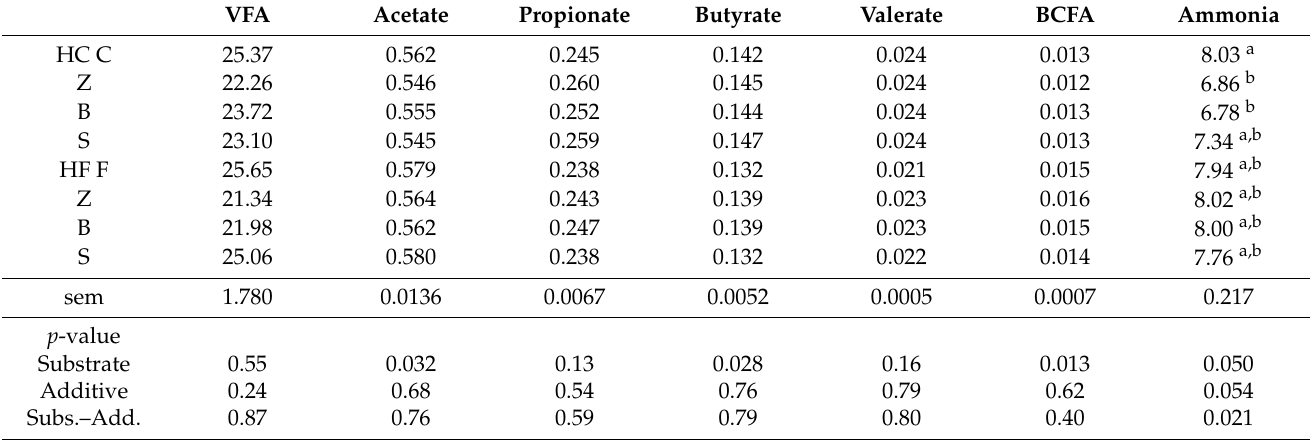
Table 5. Average total concentration (mM) and molar proportions (mmol/mmol) of volatile fatty acids (VFA) and ammonia concentration (mM) recorded at 12 h from a 65:35 (HC) or a 35:65 (HF) concentrate-to-forage substrate, alone (C, F) or supplemented with 10 mg/g of clay minerals (zeolite, Z; bentonite, B; or sepiolite,